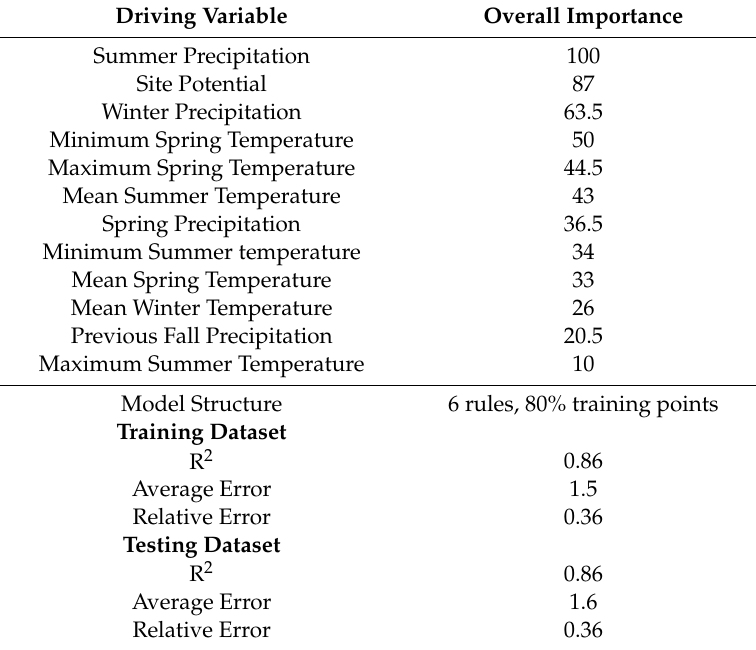
Table 2. Driving variables and their overall importance in the EEP model. Overall importance was calculated as a mean of frequency of usage in model stratification and prediction (%).